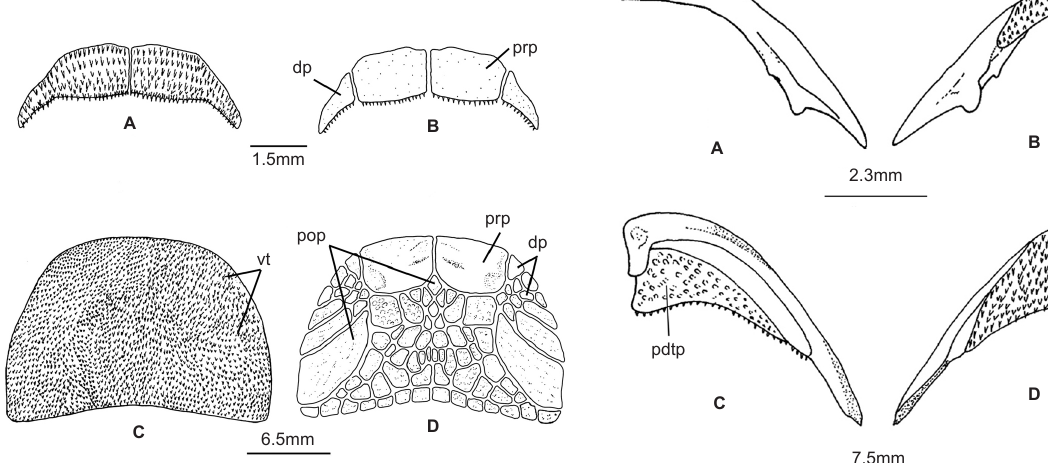
Figure 1. Premaxillary: A - ventral, B - dorsal view of Glyptothorax manipurensis (MUMF 4030); C - ventral; D - dorsal view of G . chindwinica (MUMF 9997) dp - distal element; prp - proximal element; pop - posterior element; vt - villiform teeth.